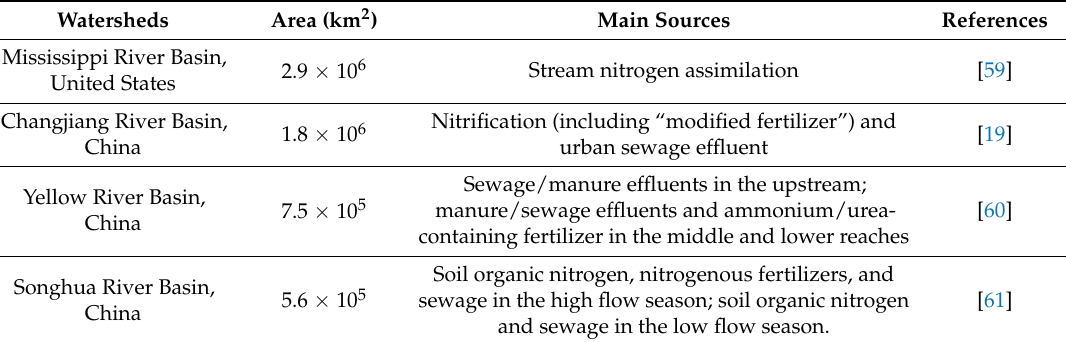
Table 1. Application of nitrogen and oxygen isotopes for the identification of nitrate source and fate in surface water in large-scale